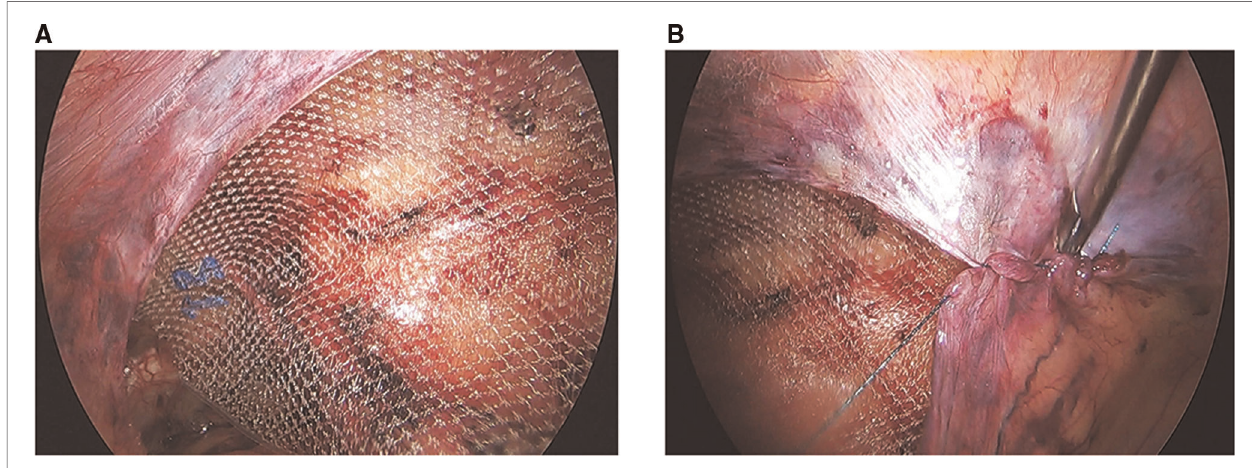
FIGURE 1 | ( A ) The 3D max mesh was placed to cover the myopectineal ori fi ce after the anterior peritoneal space was separated in transabdominal preperitoneal (TAPP). ( B ) The incised peritoneum was sutured with agnail stitches in